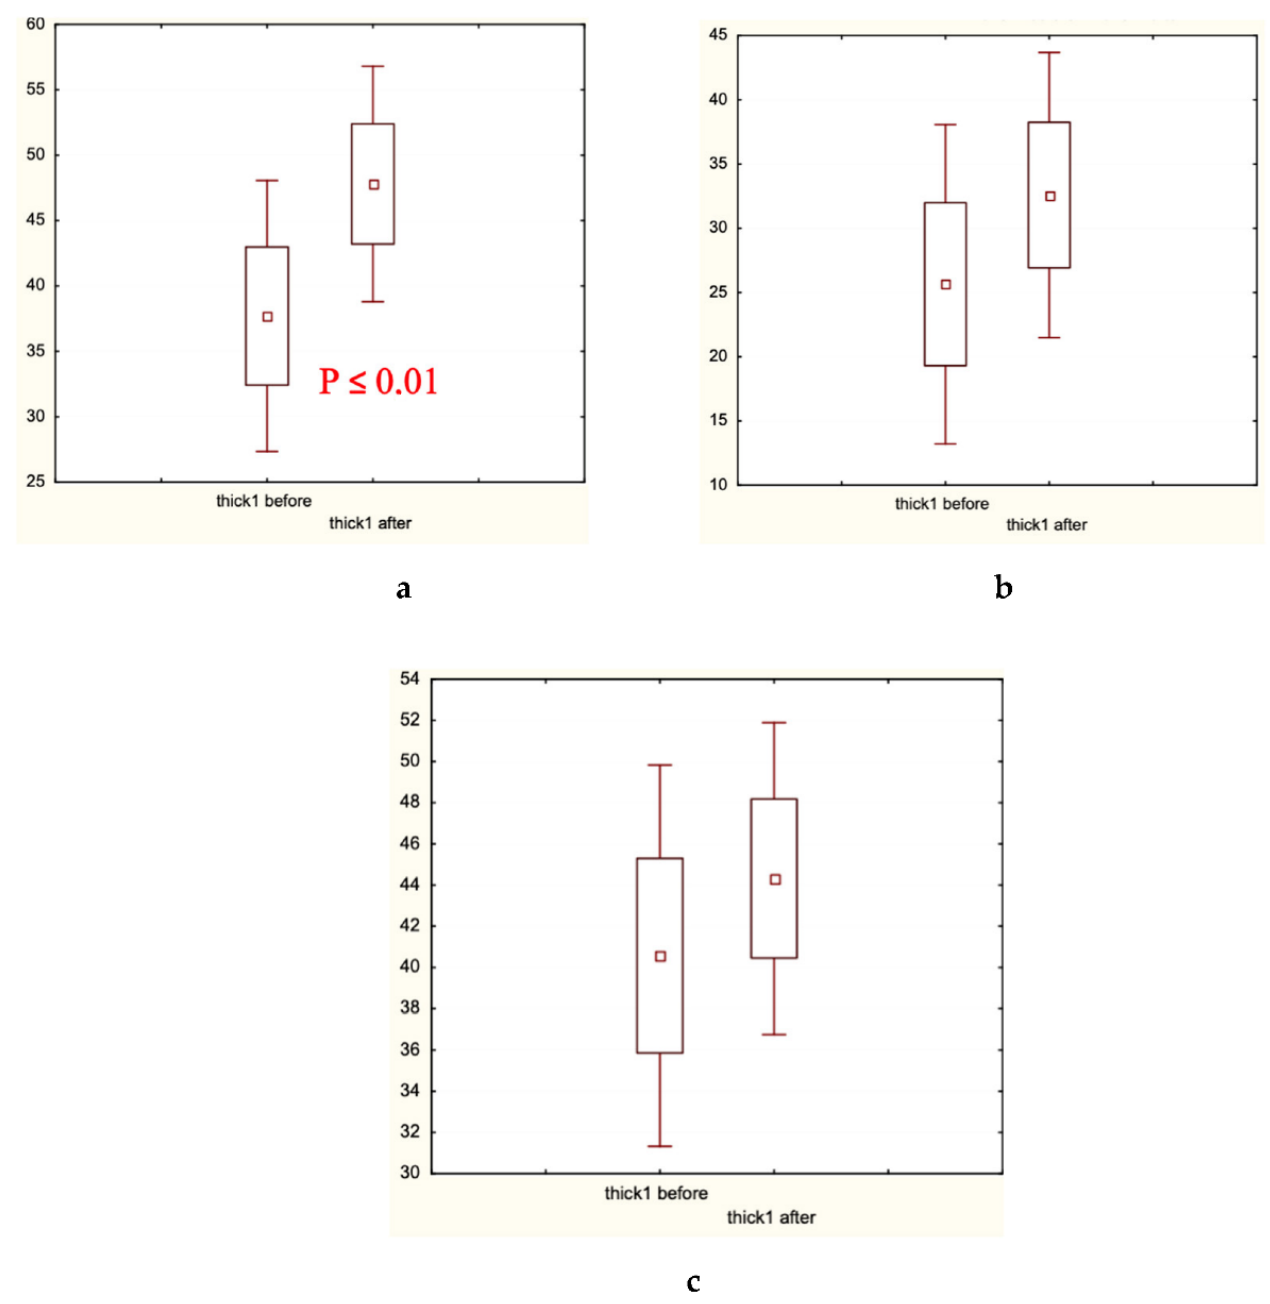
Figure 7. Thick hair presence (%) before and after the trial: ( a ) Experimental Group 1; ( b ) Placebo Control Group 2; ( c ) Caffeine Control Group 3. Small boxes—median values; large boxes—median values ± standard error of median (SEM); whiskers—median values ± 1.96 SEM. p < 0.01.